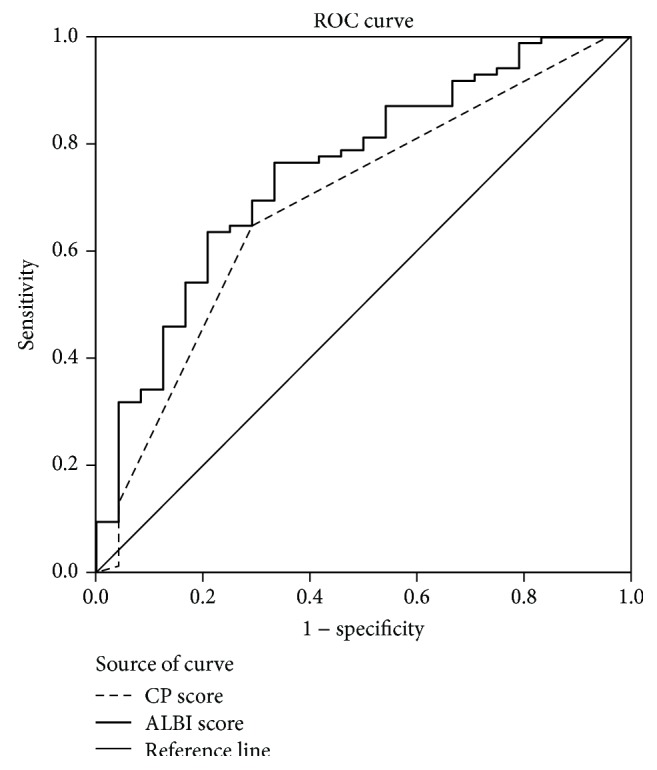
Predictive potentials of CP vs. ALBI scores for detecting postoperative death.